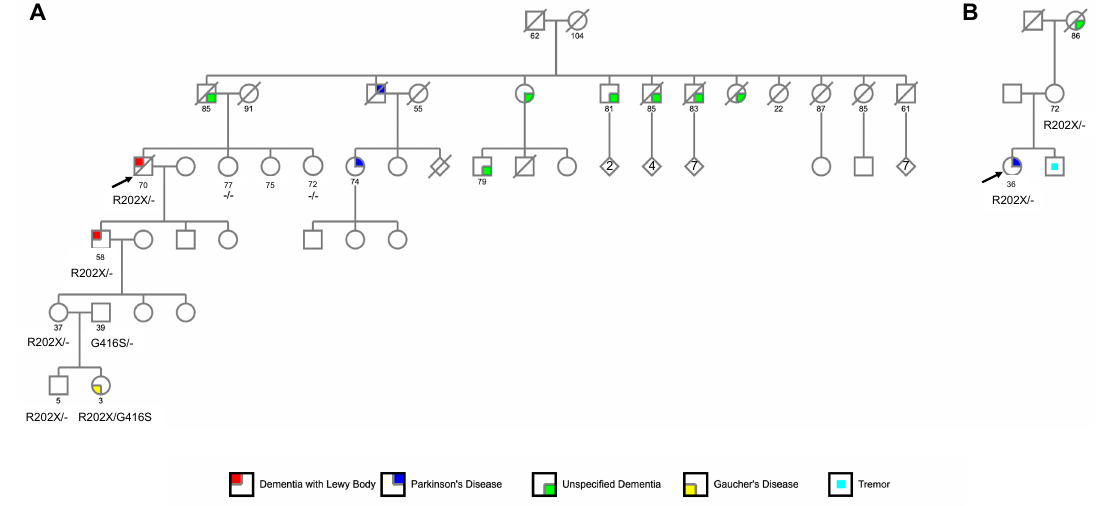
Figure 3. Pedigree of the reported LBSD families. Family 1 ( panel ( A )) and Family 2 ( panel ( B )). Arrows indicate the index cases.